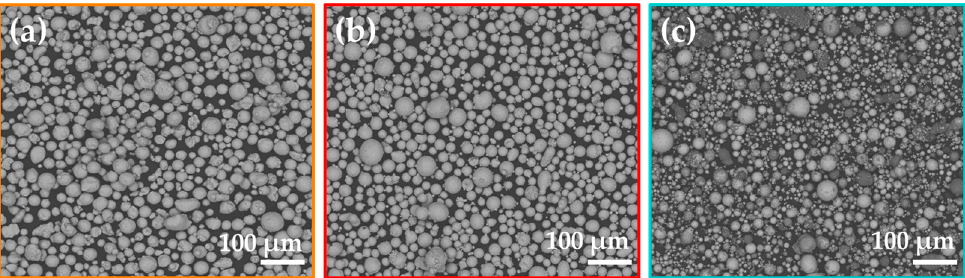
Figure 7. SEM images of commercial reference materials in AM: ( a ) 316 L, ( b ) H11/1.2343, ( c ) eroded particles from SE_01-MT.